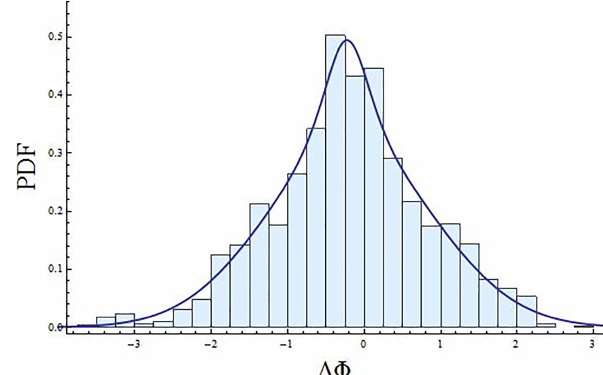
Figure 3. Histogram with bin width of 15 (cid:48) ; the blue continuous curve is the statistical distribution f inferred for Ptolemy’s set.